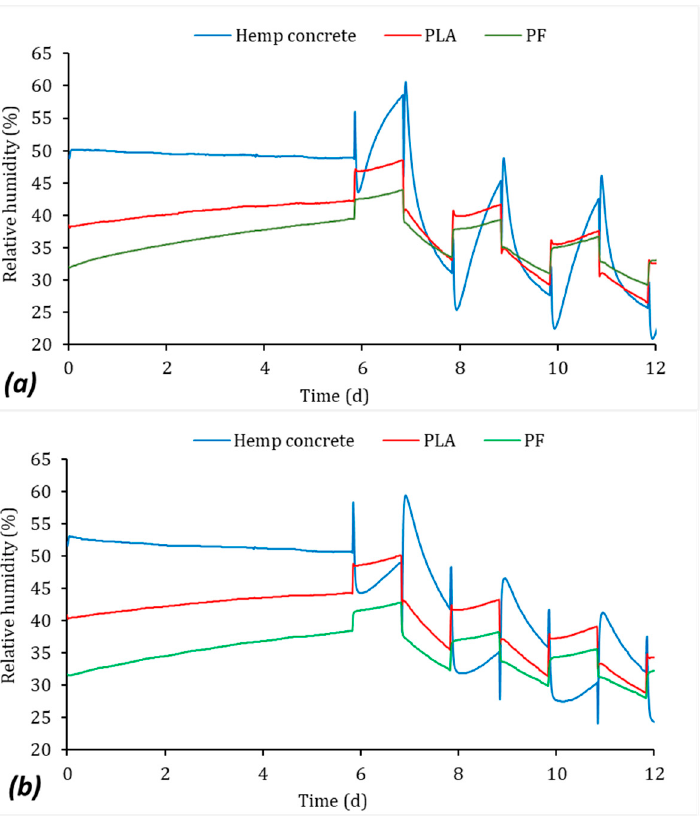
Figure 14. Relative humidity evolution within the studied samples (infill 10%) at a depth of ( a ) 2.5 cm and ( b ) 5 cm.